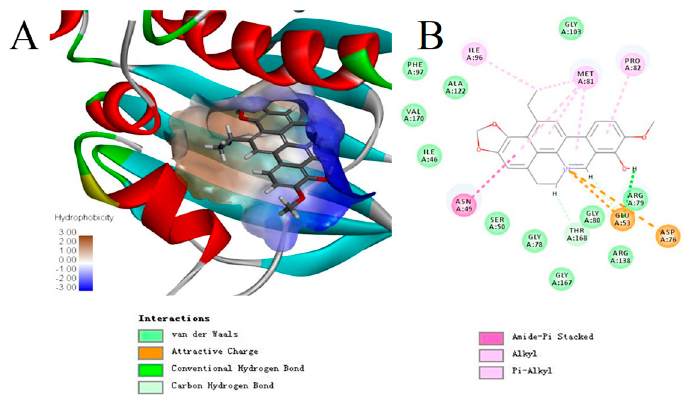
Figure 4. (A) Solid surface map of the interaction pocket with compound 15a . Red, blue, and white colored regions correspond to negatively charged, positively charged, and neutral areas, respectively. (B) Binding modes within the receptor S. aureus topo Ⅳ active pocket. These figures were produced using the Discovery Studio 4.5 software. The receptor structure is shown in surface form. Key bonds are indicated by dashed lines between the atoms involved, and the colors of key bonds and residues are shown according to the interaction mode (van der Waals, light green; attractive charge, orange; hydrogen bond, green; carbon hydrogen bond, celadon; amide- π stacked, amaranth; alkyl and π -alkyl, mauve pink).